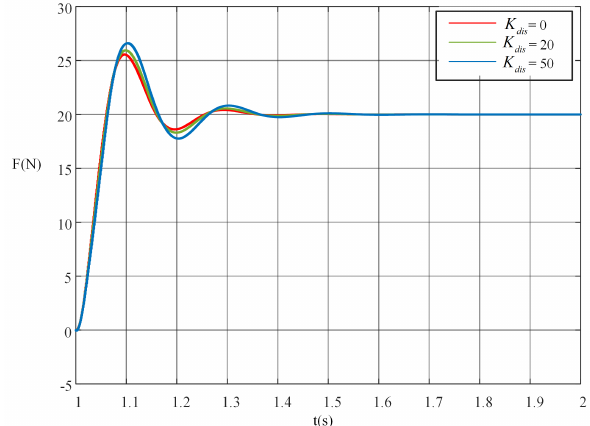
Figure 10. Force step response of the FOIC with dynamic inertia and gravity disturbance changes.